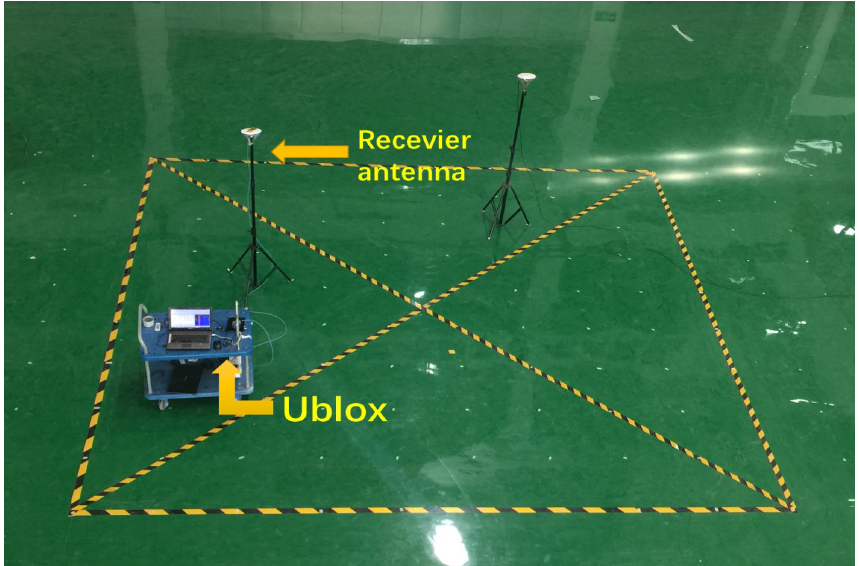
Figure 7. Ground-based navigation system receiving module.